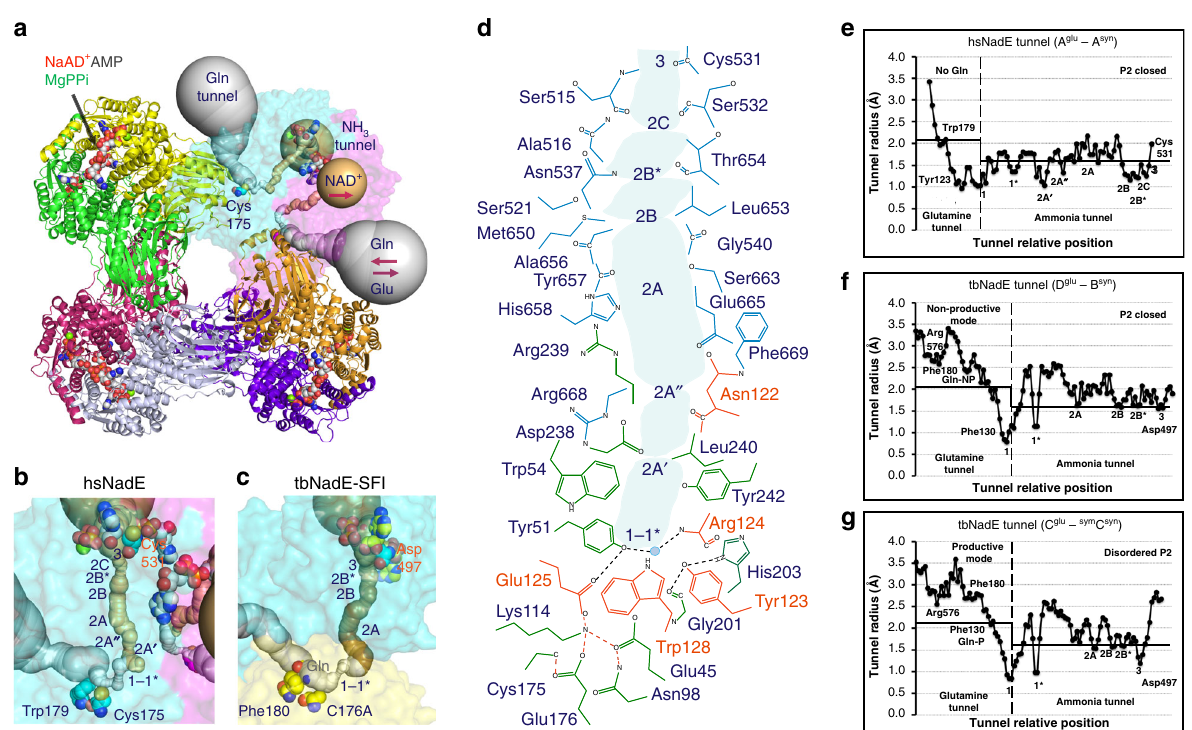
Fig. 3 Octameric assembly and molecular tunnels connecting the two active sites in hsNadE. a The biological unit of hsNadE is generated by crystal symmetry as an octamer. The glutamine and ammonia tunnels in subunits A and B are in gray and golden, respectively. The red arrow indicates the direction of the substrate/product fl ows in/out the molecular tunnel. b , c Comparison of the constrictions located in the molecular tunnels found in hsNadE ( b ) and tbNadE-SFI complexes ( c ) within the single subunit A and two subunits D glu – B syn , respectively. Key residues (glutamine-binding residue, catalytic cysteine, and last position of the ammonia transport) are shown as spheres. d Polar, nonpolar, and charged residues forming the ammonia tunnel and constrictions in the hsNadE complex. The residues lining the ammonia tunnel belong to the glutaminase domain (green), the YRE loop (orange), and the synthetase domain (cyan). A water molecule coordinated with the residues forming constriction 1-1* and the YRE loop residues is shown in gray sphere with a light blue contour and its position indicates the start of the ammonia transport. e – g Ammonia tunnel radii calculated in subunit A of hsNadE complex ( e ), in subunits D glu – B syn ( f ), and in subunits C glu - sym C syn ( g ) of the tbNadE – SFI complex. The dashed line at constriction 1-1* shows the boundary of the glutamine and ammonia tunnels. 2.1 and 1.6 Å cut-off radii are used for the glutamine and ammonia tunnels, respectively. Location of the glutamine-binding site is de fi ned by Tyr123 HS /Phe130 TB and Trp179 HS /Phe180 TB . The last position of ammonia in the ammonia tunnel is marked by Cys531 HS /Asp497 TB